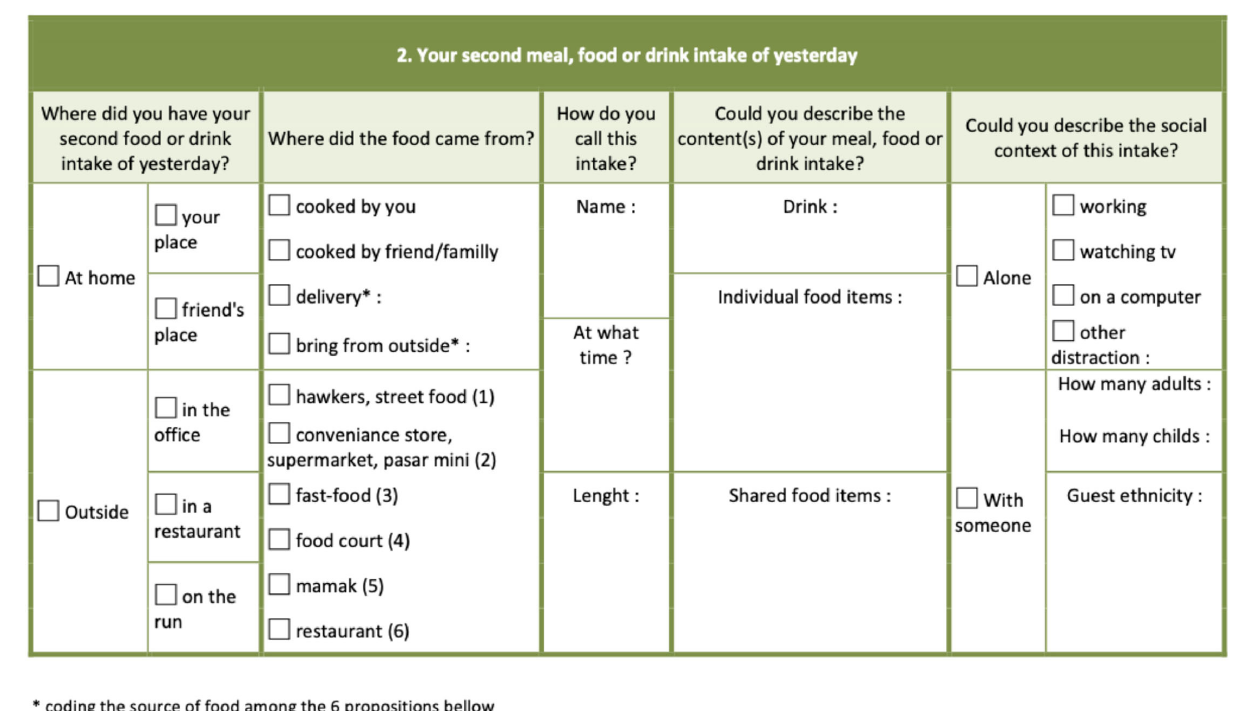
FIGURE 2 | Adapted 24-h recall, food intake recording